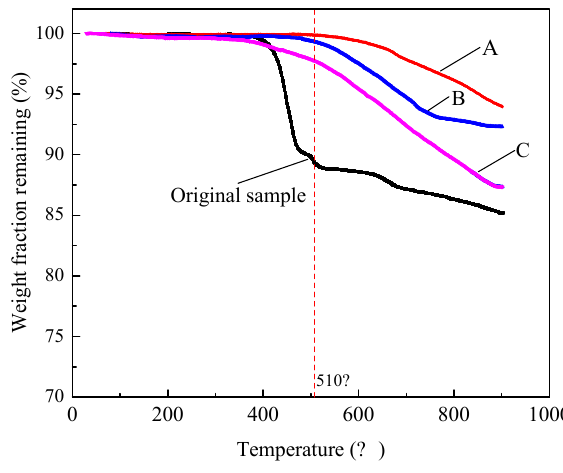
Figure 10. TG curves of oil shale after pyrolysis.